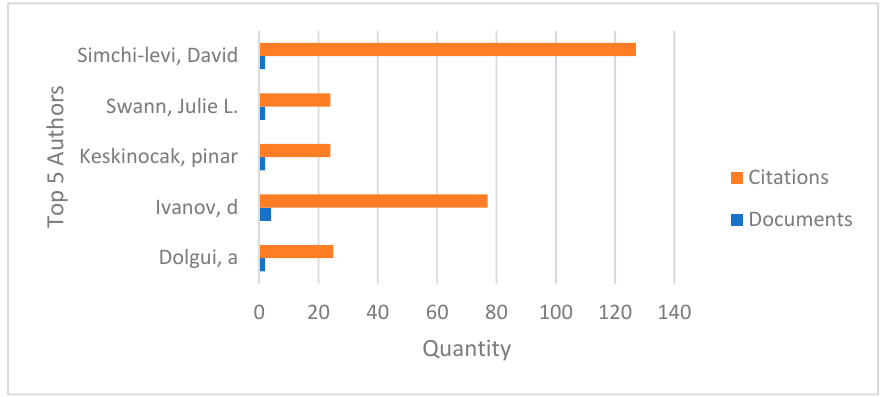
Figure 6. Stacked Author Network analysis.